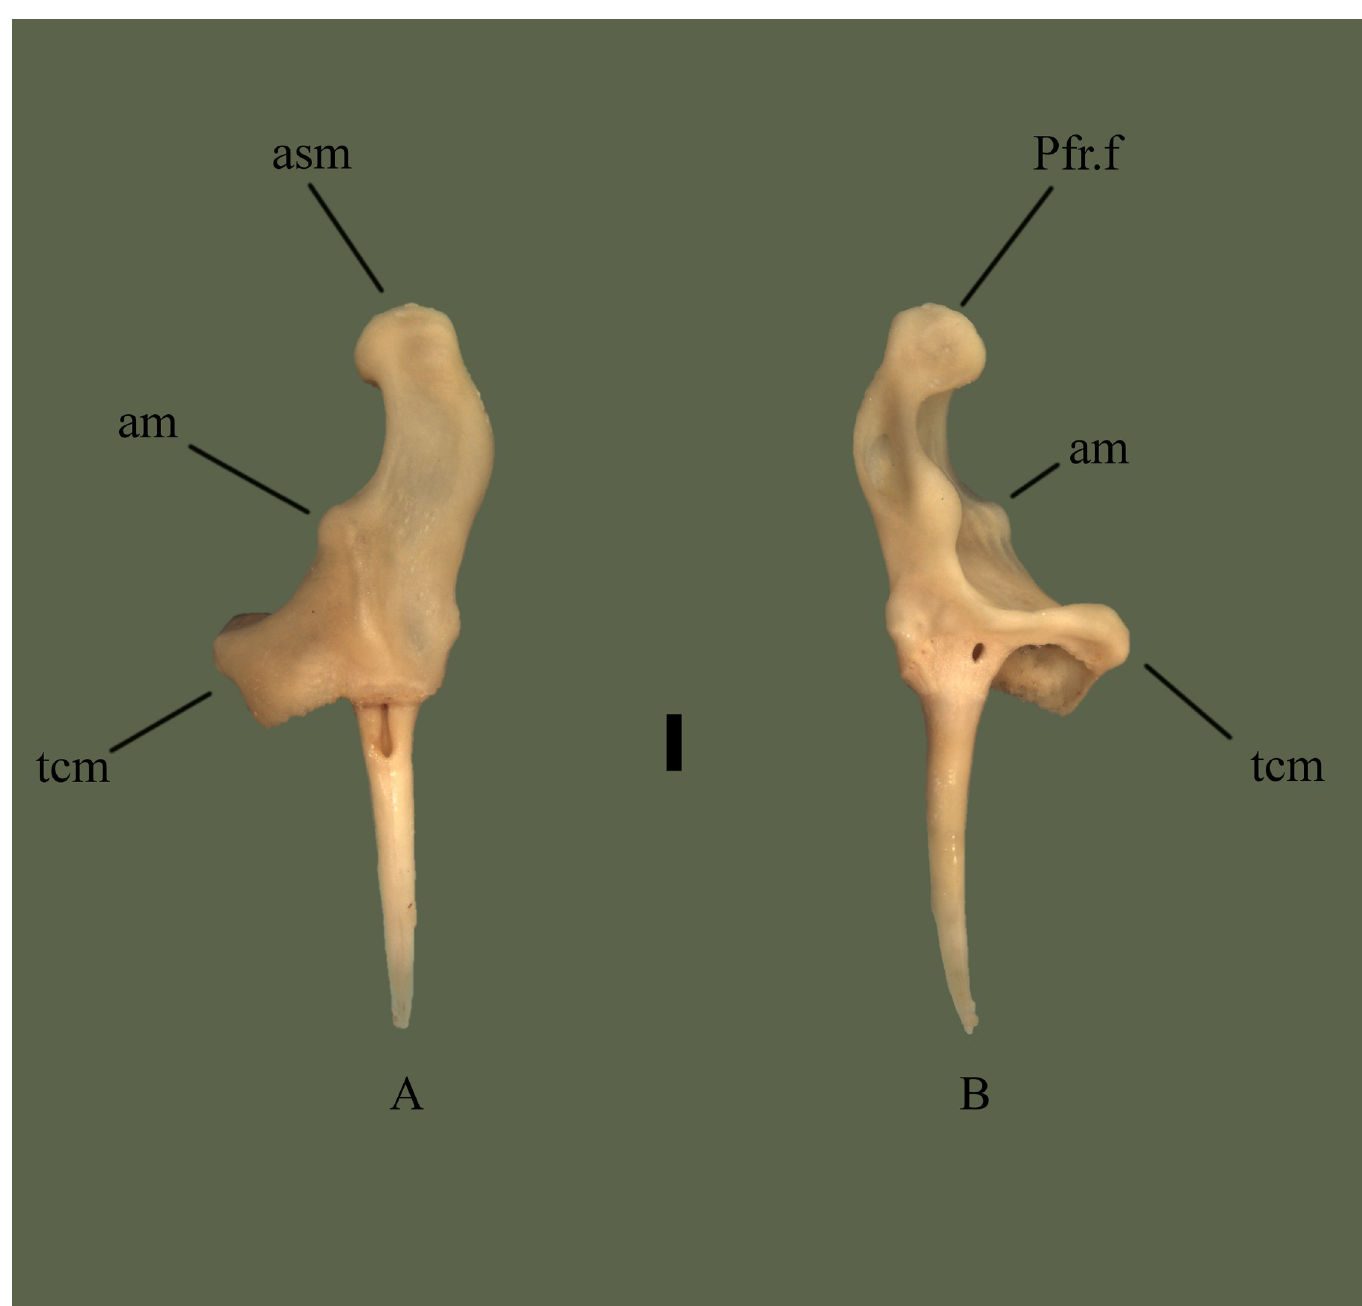
Fig 9. Right maxilla (ETVP 3306) in anterior (A) and posterior (B). Scale bar = 1mm. Abbreviations: Pfr.f = prefrontal facet; am = anterior process of maxilla; asm = ascending process of maxilla; tcm = transverse crest of